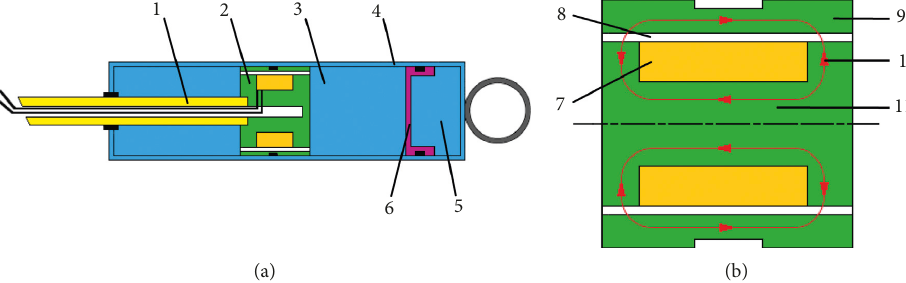
Figure 1: (a) Section view of a single-tube MR damper. (b) Magnetic circuit in a MR damper piston. 1, piston rod; 2, piston; 3, MRF reservoir; 4, housing; 5, compressed gas reservoir; 6, accumulator piston; 7, coil; 8, MRF gap; 9, iron sleeve; 10, flux; 11, core [31].